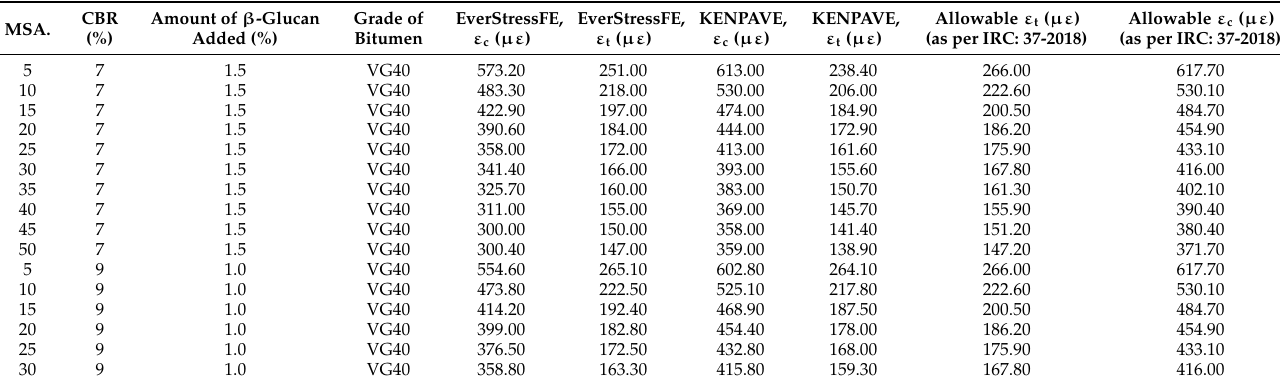
Table 2. Comparison of critical